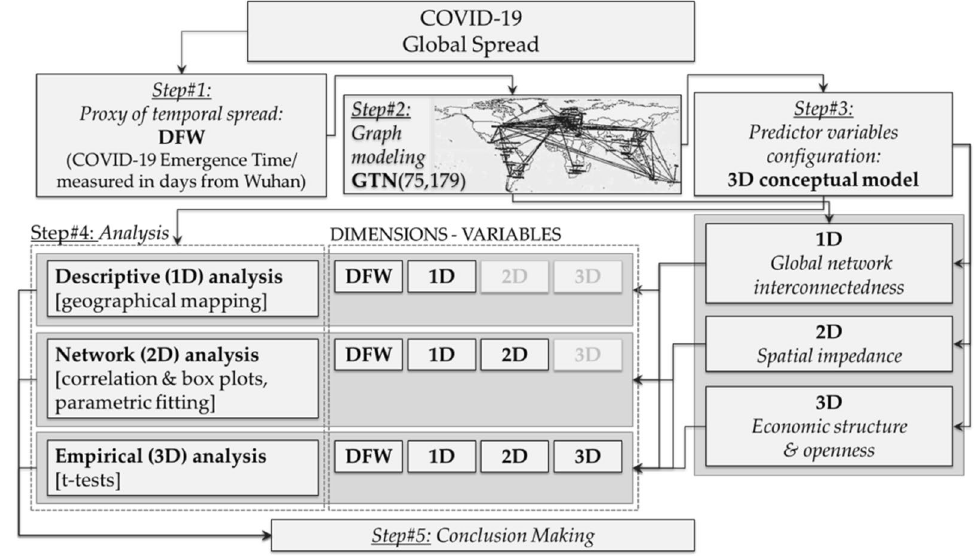
Figure 1. The conceptual framework of the study.